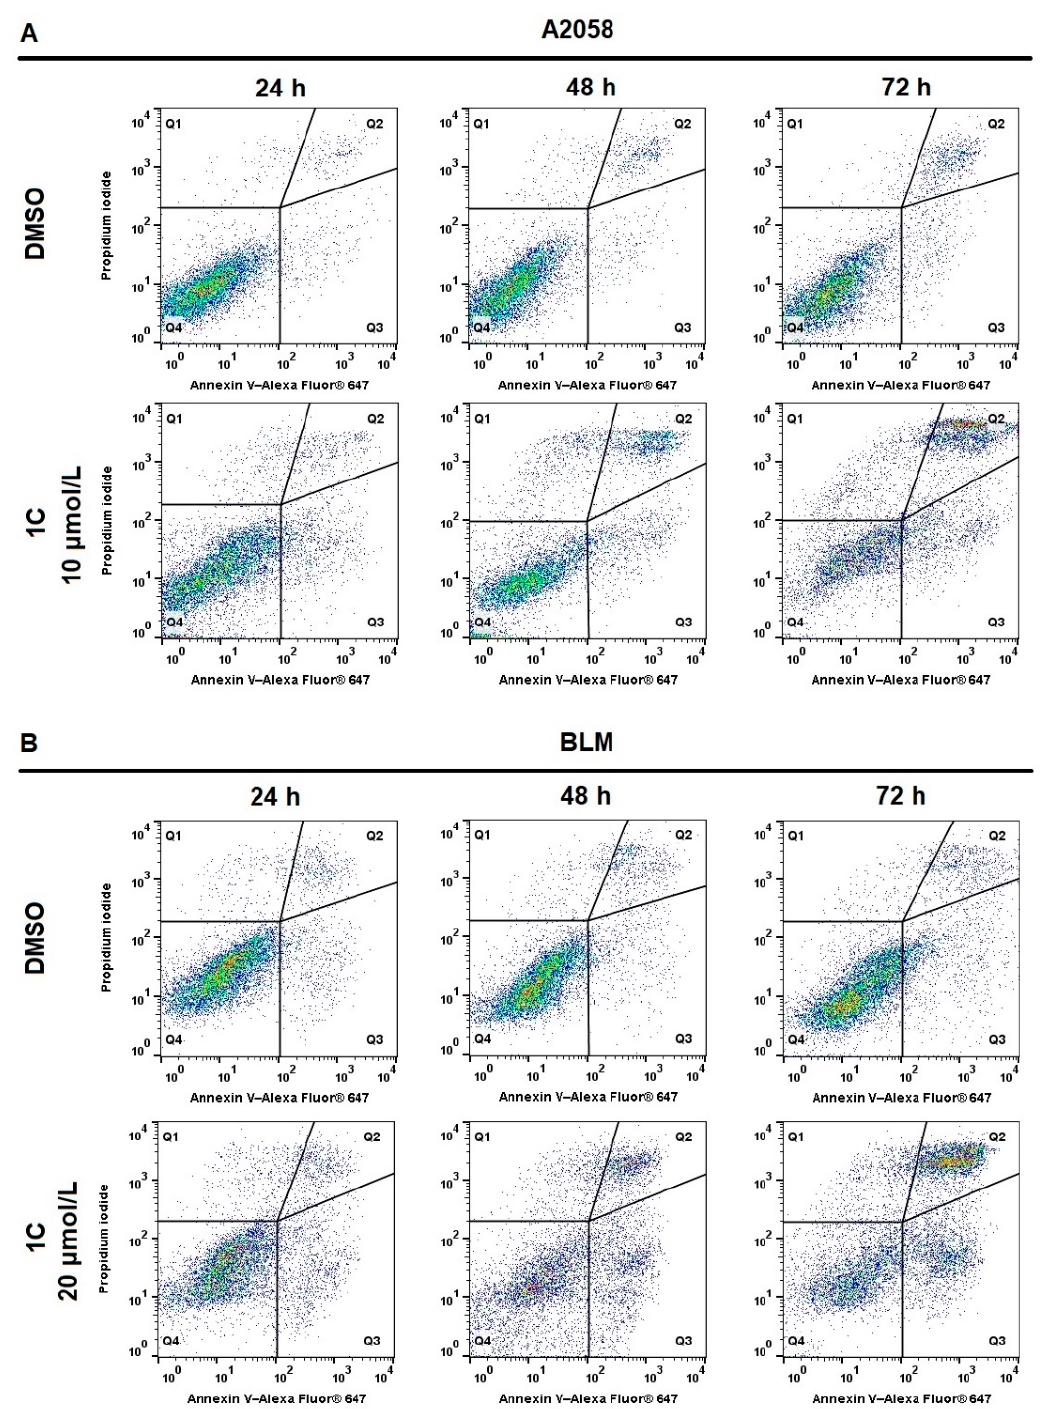
Figure 4. Flow cytometric analysis of 1C -induced apoptosis after 24, 48 and 72 h in ( A ) A2058 (10 µ mol/L) and ( B ) BLM (20 µ mol/L) melanoma cells using Annexin V/PI staining. Representative dot plots from three independent experiments.